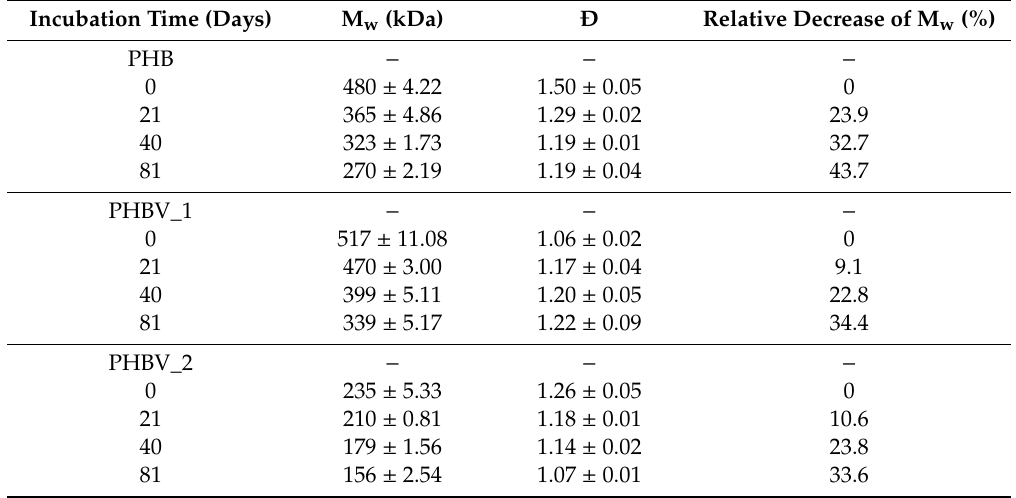
Table 6. Molecular weight changes in the PHA sca ff olds in vitro at 37 ◦ C in a phosphate bu ff er saline solution with lipase determined by